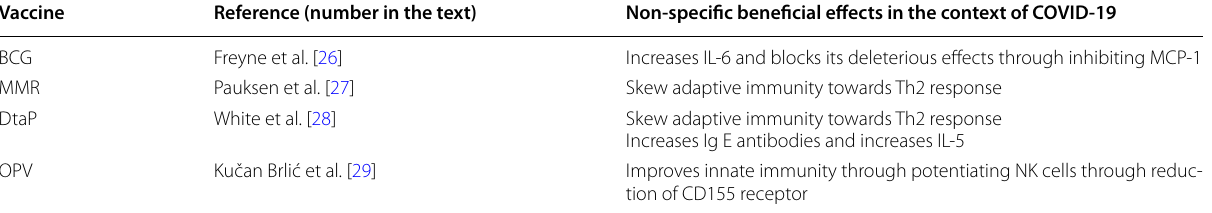
Table 1 Example of routine immunizations and their non‑specific effects on the immune system towards a beneficial response against